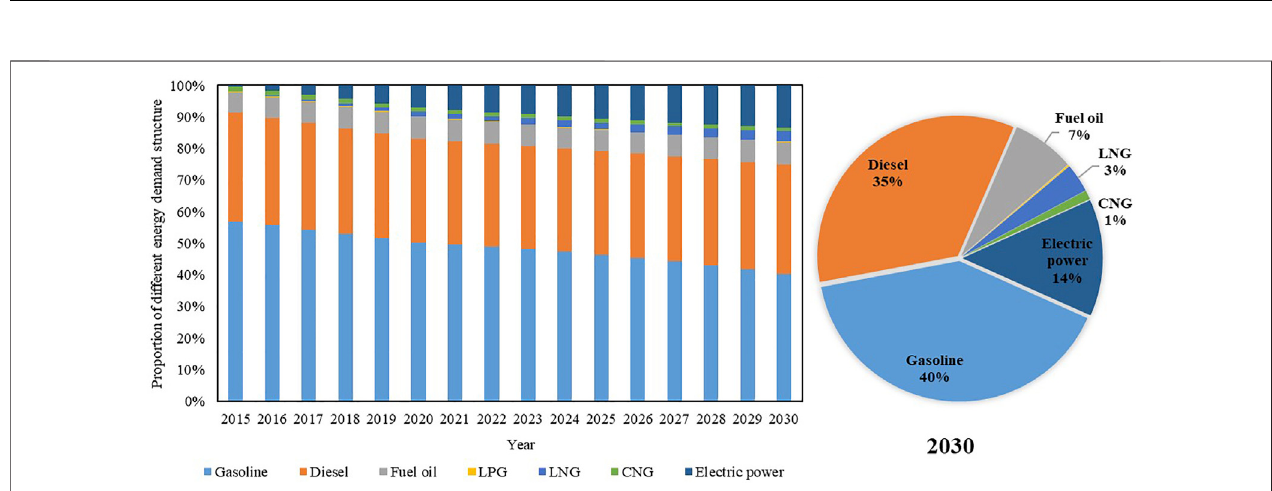
FIGURE 6 | Prediction of energy demand structures of transportation under the low-carbon scenario in Guangdong Province.